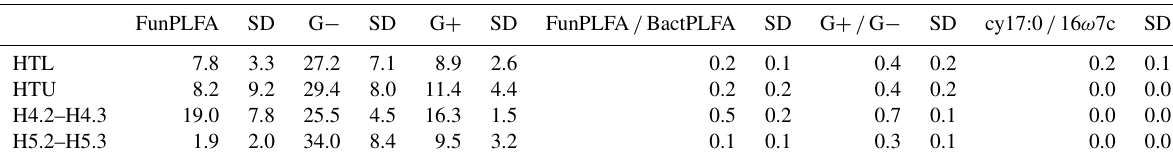
Table 3. FunPLFA / BactPLFA, G − / G + and cy17:0 / 16:1 ω 7c ratios averaged in the upper aquifer (HTU) and lower aquifer (HTL) as well as in the anoxic groundwater at locations H4 and H5.